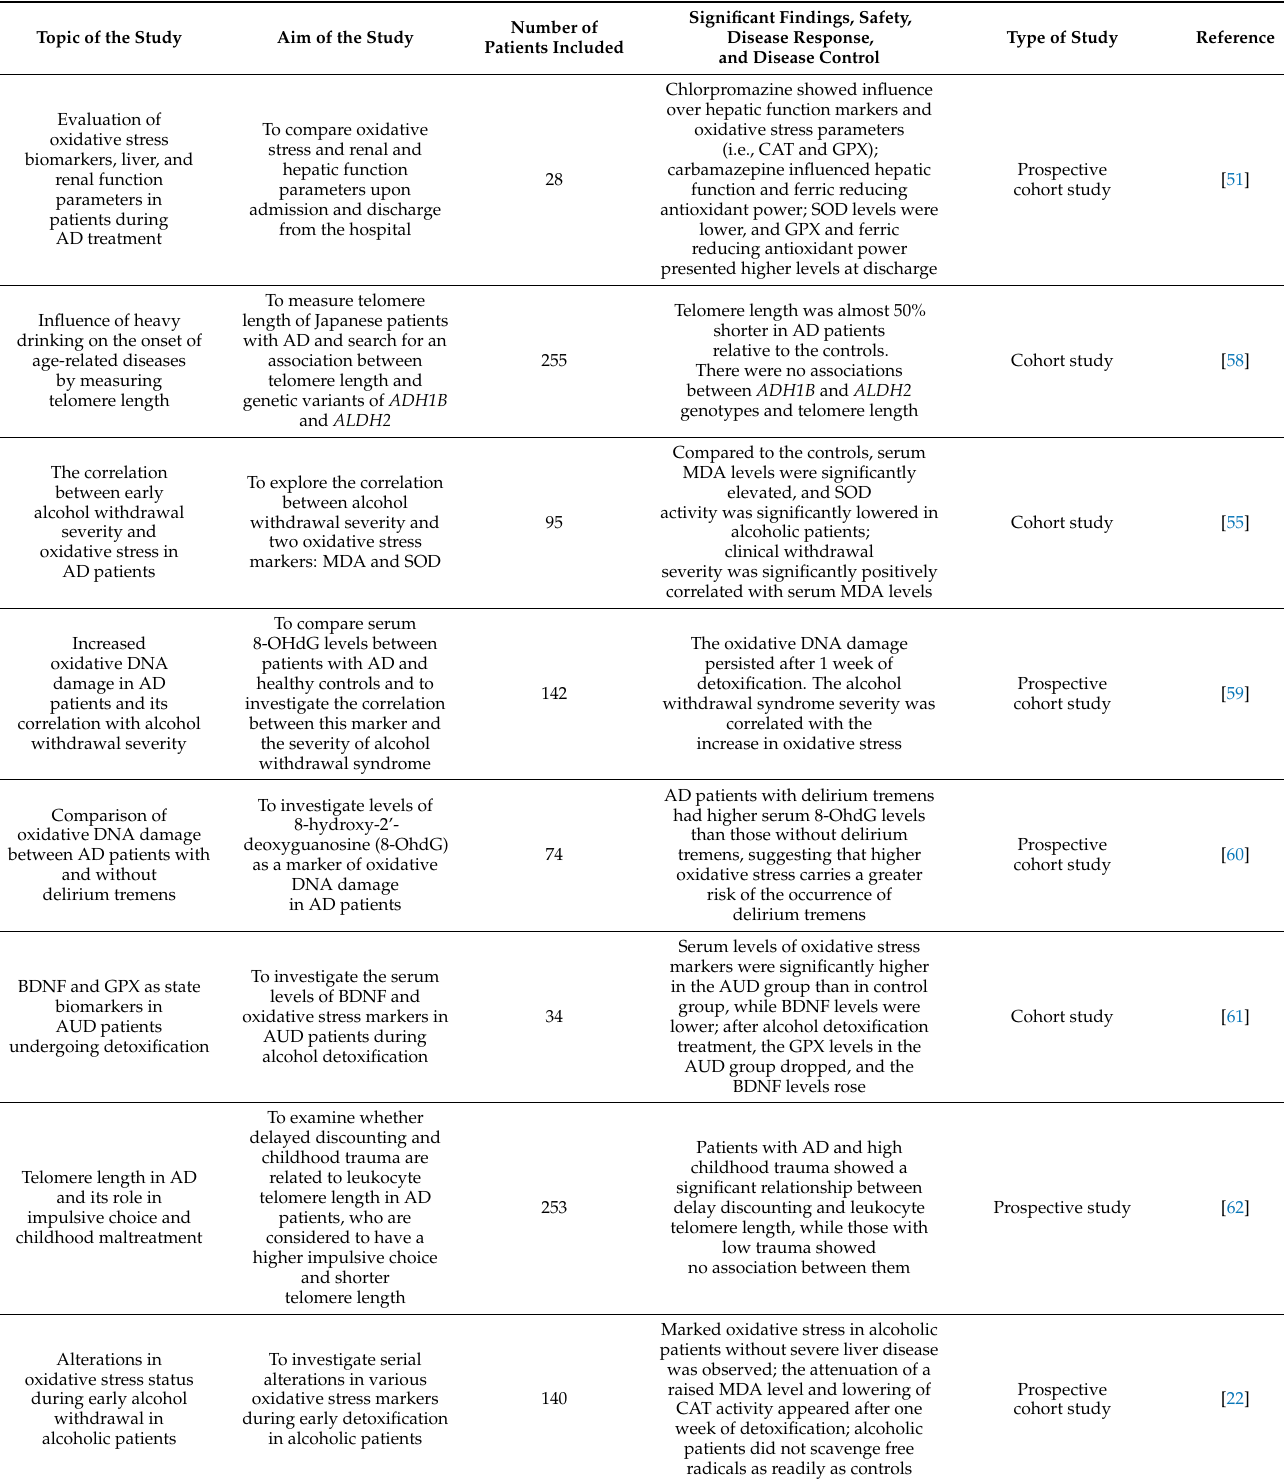
Table 1. Overview of clinical studies on AUD and oxidative